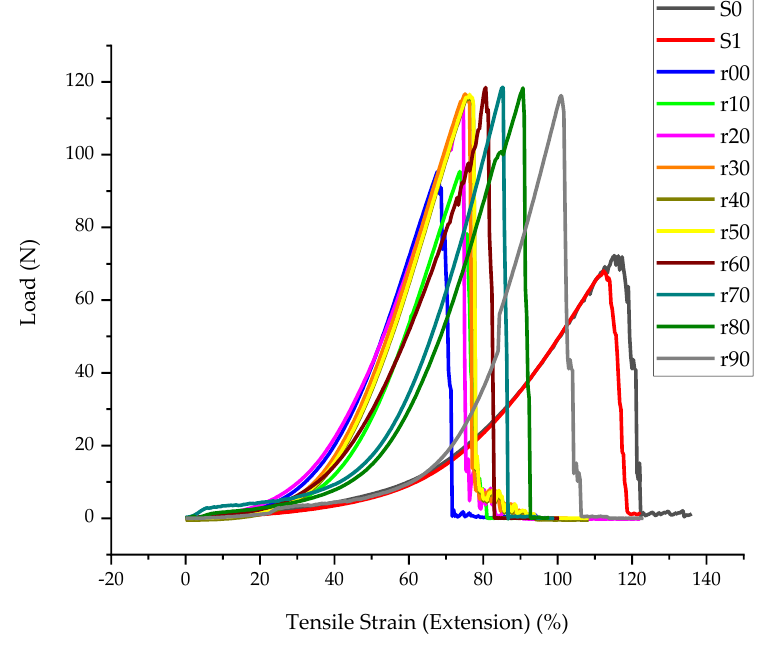
Figure 8. Load-elongation curve.